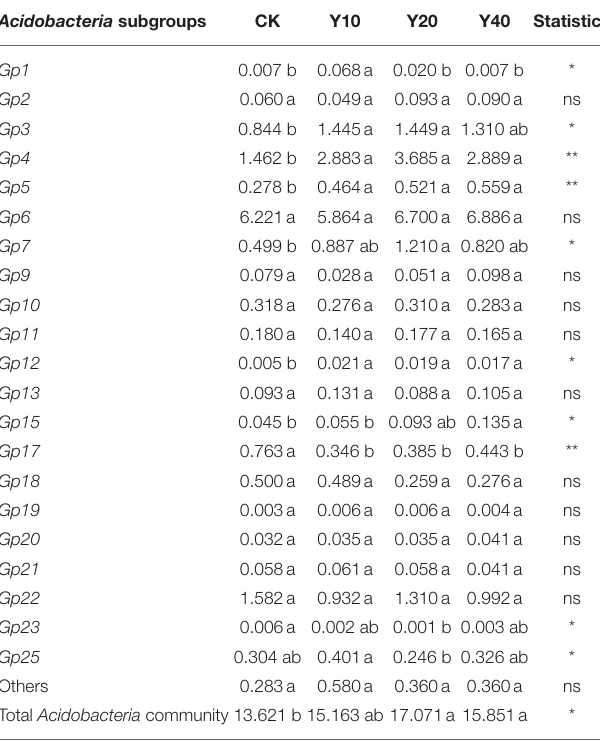
TABLE 4 | Percentage of Acidobacteria subgroup abundance relative to all bacterial communities. Acidobacteria